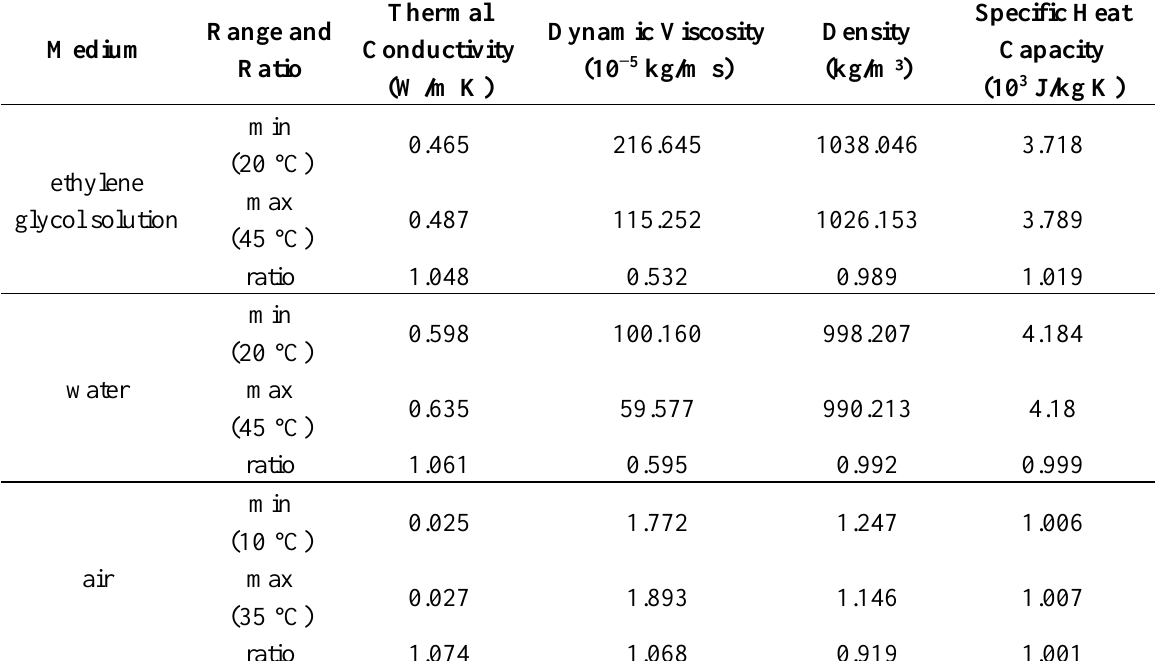
Table 1. Thermodynamic properties of ethylene glycol solution, water and dry air at different temperatures (at 1 atm) and non-dimensional ratio between properties at the minimum temperature and the maximum temperature. Data calculated with CoolProp ([14] and